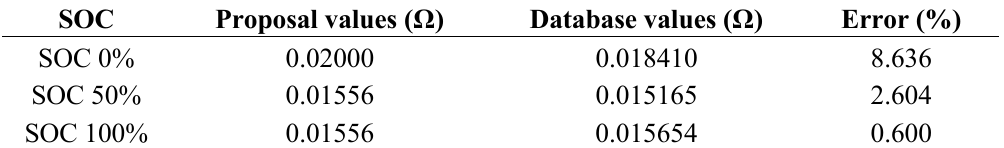
Table 2. Accuracy comparison of proposal method and ITRI